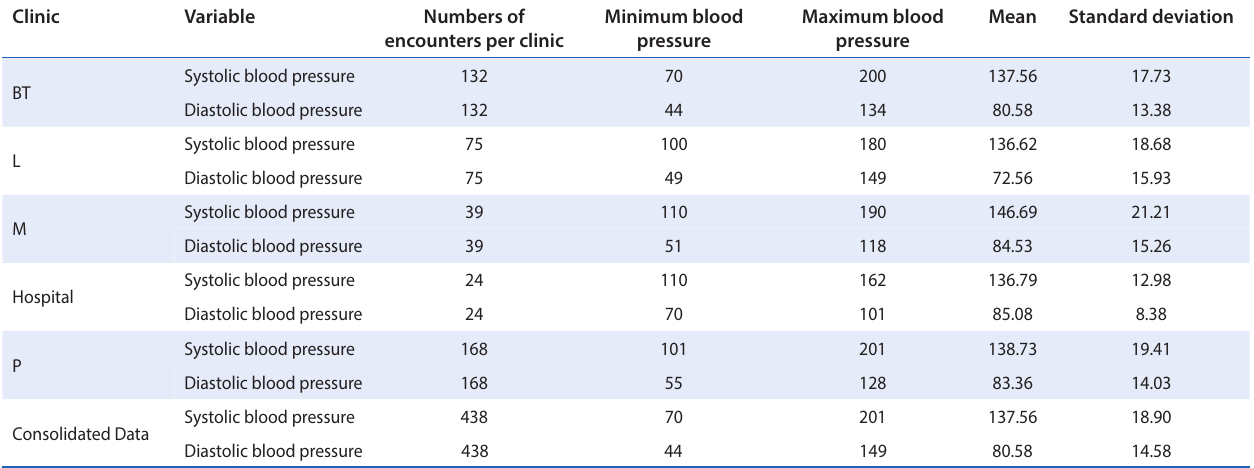
Table 5: Systolic and diastolic blood pressure as measured on initial and all subsequent visits Clinic